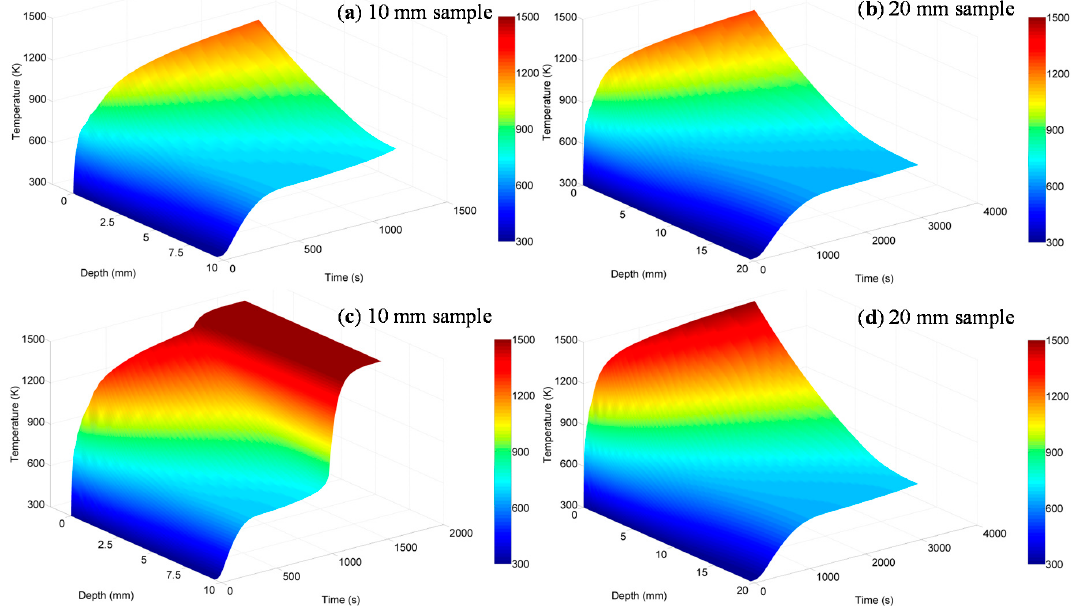
Figure 8. The temperatures inside PC slabs under heat fluxes for: ( a , b ) 50 kW/m 2 ; and ( c , d ) 75 kW/m 2 .